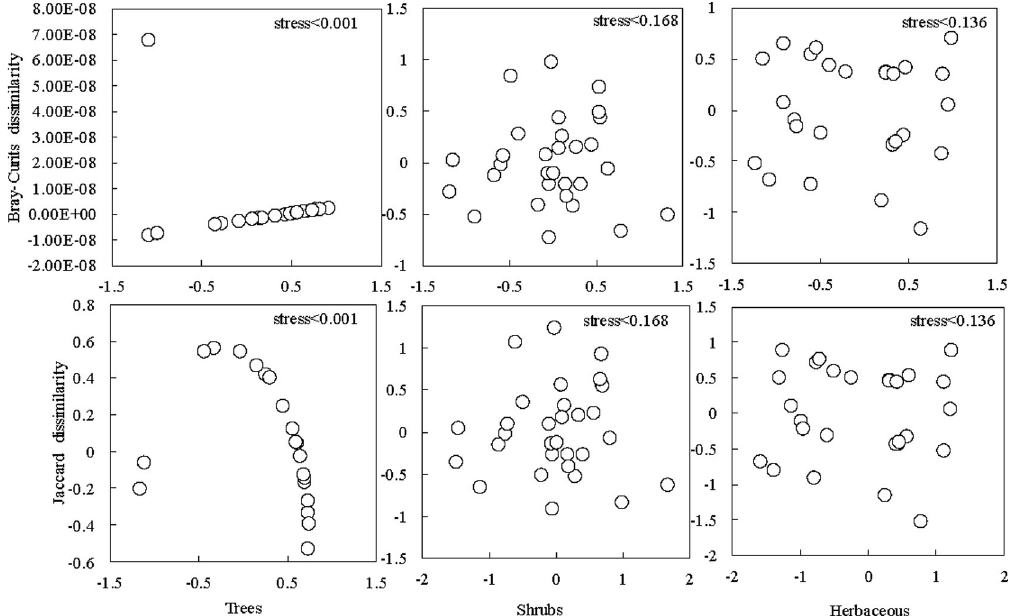
Fig 2. The changes in the beta diversity of different plant